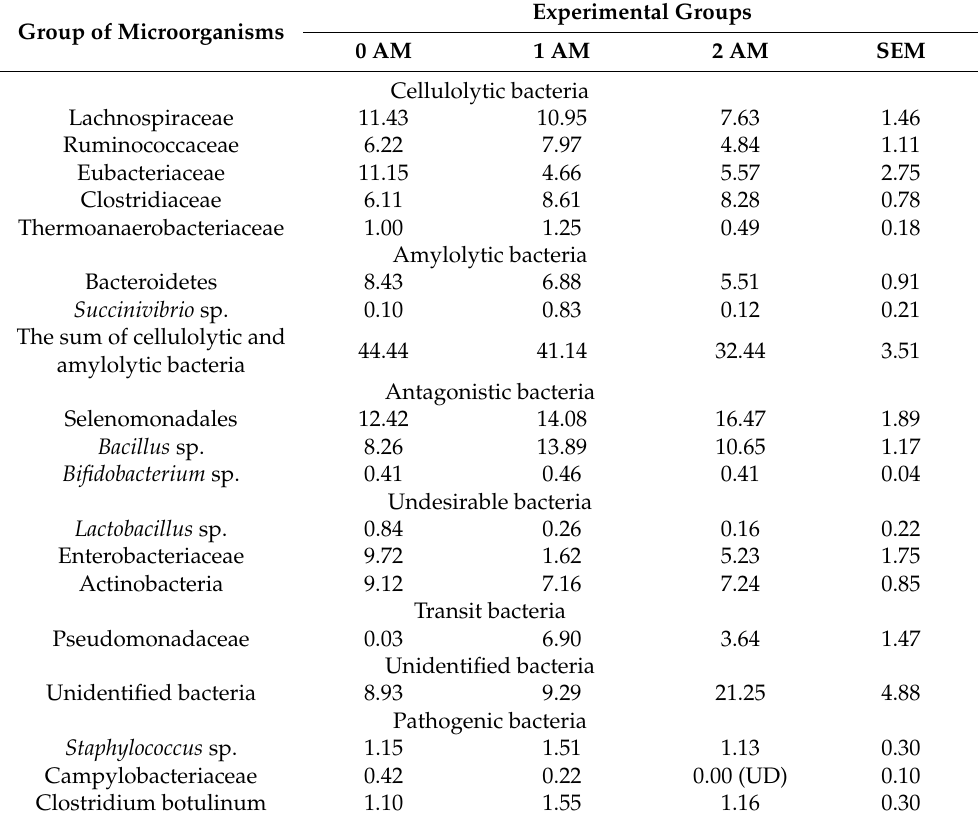
Table 6. Percentages of rumen microbiota of Ayrshire dairy cows during the early lactation period (DIM = 120).